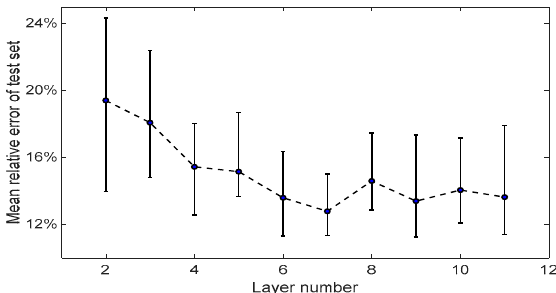
Figure 4. Training and testing using the spectral band of approximately 12.5 to 16.5 MHz with different layer numbers. The minimum, maximum, and average of MREs of test set for 10 retrainings are drawn for each layer number.